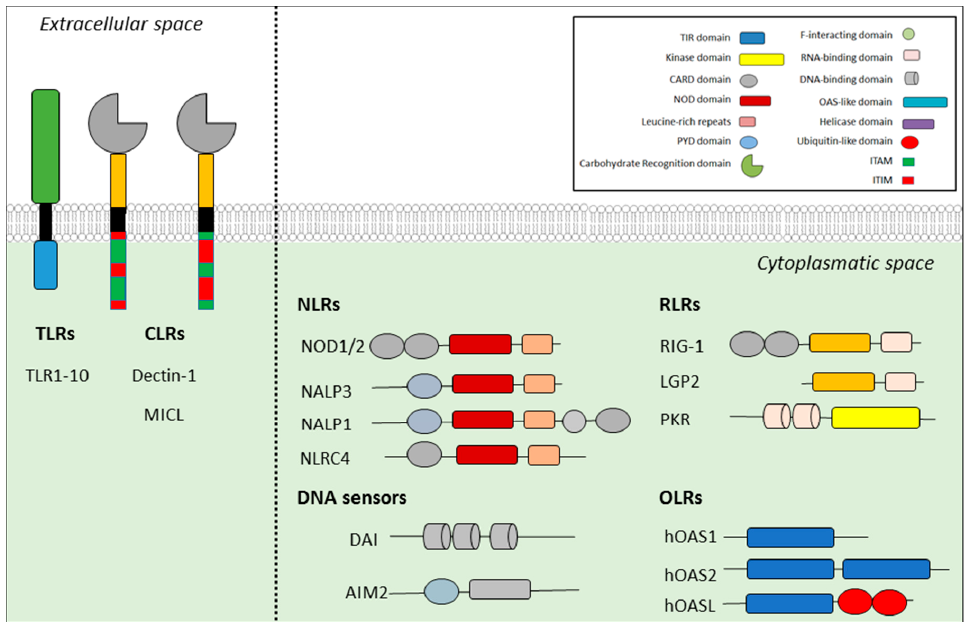
Figure 1. Cellular pattern recognition receptors (PRRs). Toll-like receptors (TLRs) are transmembrane receptors expressed in cellular and endosomal membranes, which are comprised of 10